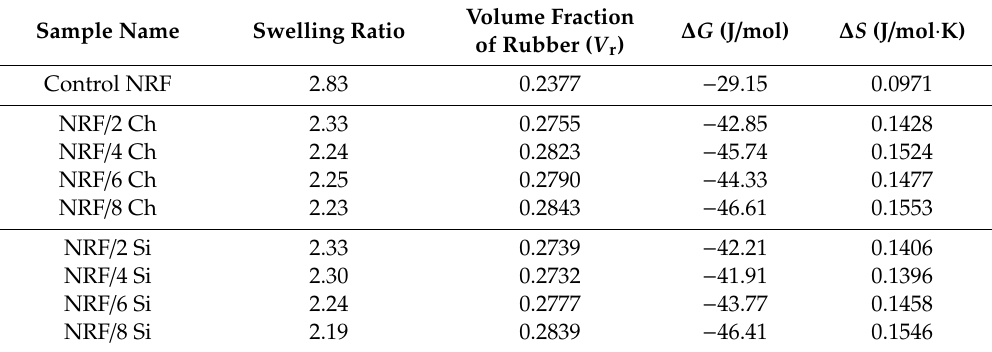
Table 4. Calculated parameters from crosslinking density results for the control NRF and NRF with various